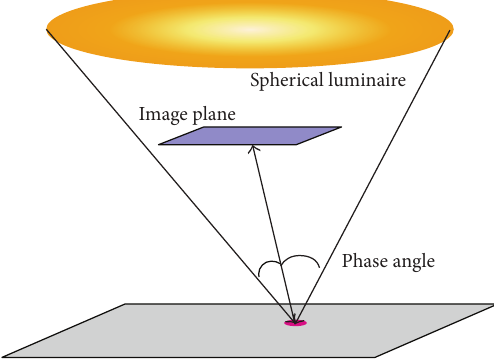
Figure 9: Monte Carlo ray tracing of a spherical